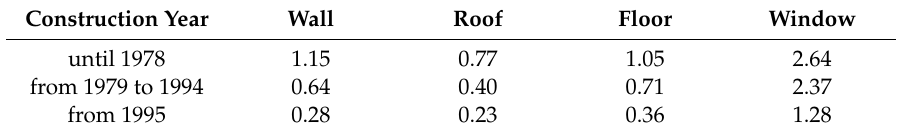
Construction year Wall Roof